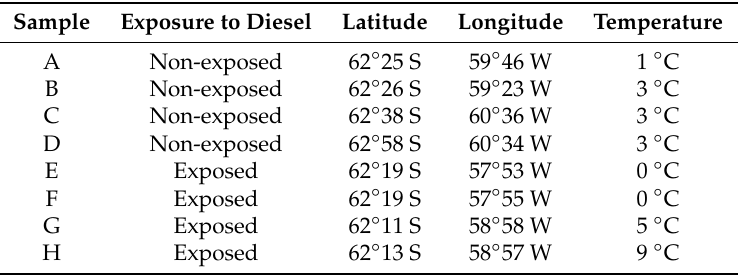
Table 1. Location and characteristics of Antarctic soil